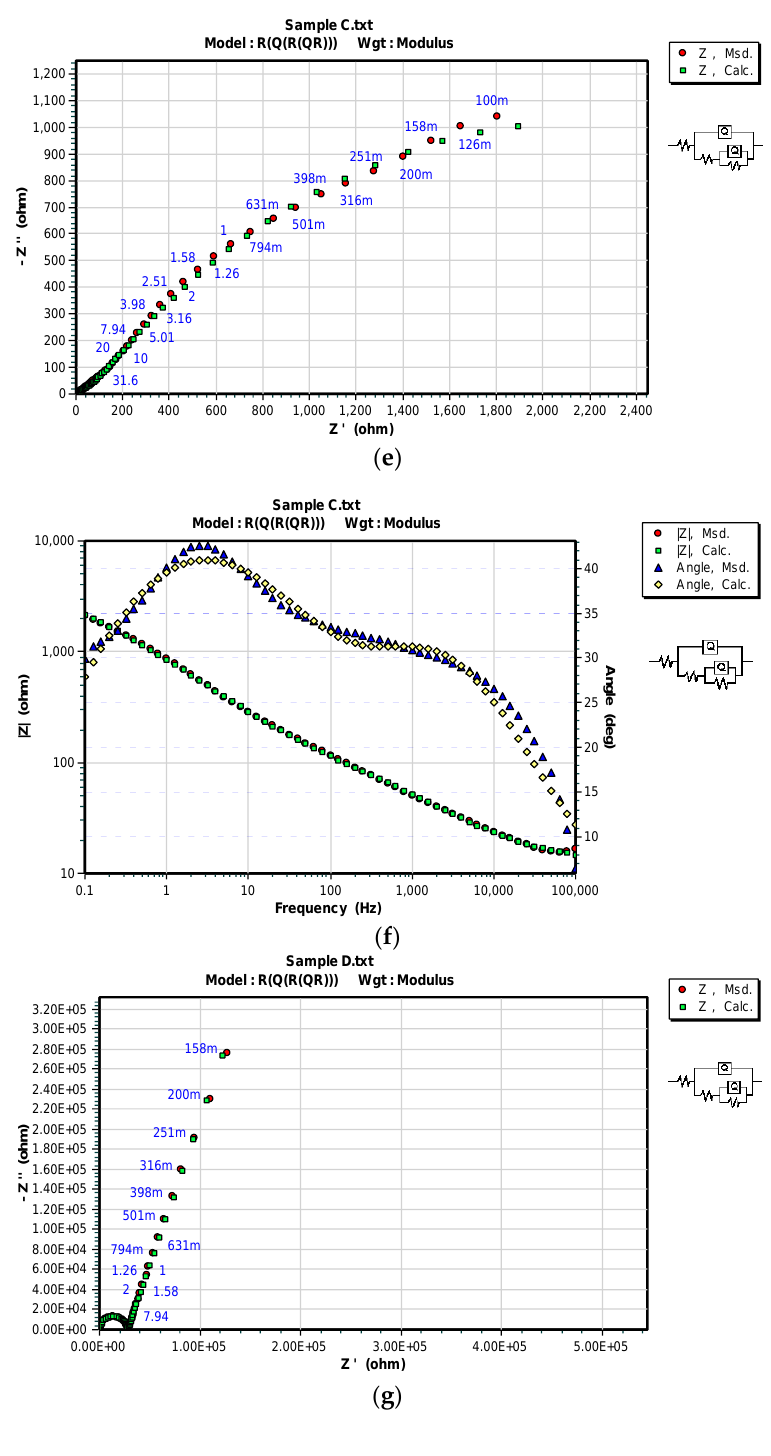
Figure 4. Cont. Figure 4.